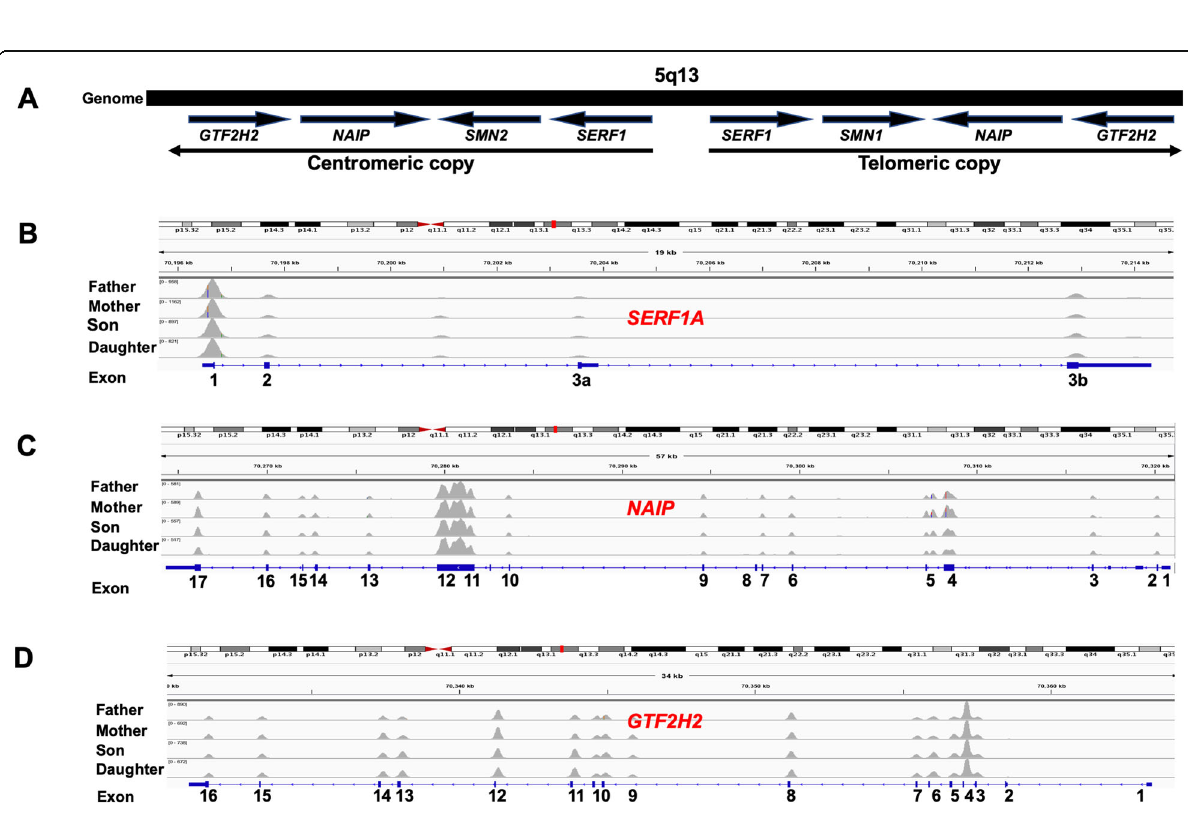
Fig. 2 Genetic map of SMA related locus and reads coverages of candidate SMA modifiers. a SMN and their surrounding genes are contained within two large inverted genomic fragments within the region on chromosome 5q13. SMN1 is located within the telomeric copy whereas SMN2 is contained within the centromeric copy. The surrounding genes include SERF1 , NAIP and GTF2H2, which are reported as candidate modifiers in SMA. The arrows indicate their directions. b , c , d The reads coverages in the b SERF1, c NAIP and d GTF2H2 exon regions for each family member. The grey peaks indicate the richness of the reads that mapped to the corresponding exon region in each